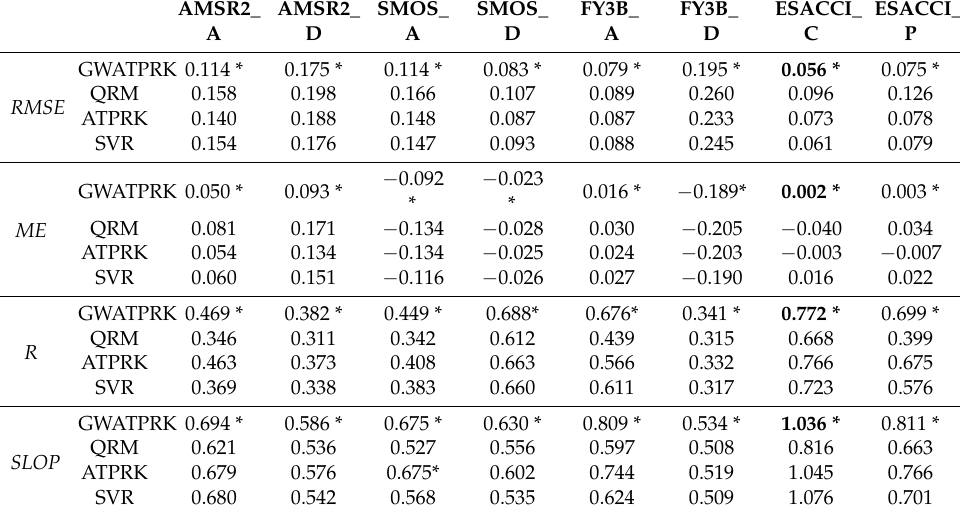
Table 3. Spatial statistics of comparisons between 1 km downscaled predictions and ground-based measurements for the different cases in the Naqu area. (The bold values represent the best performance of all downscaling predictions for each validation index. In each validation index, the values with * mean the best performance of different downscaling predictions from the same satellite-based SSM